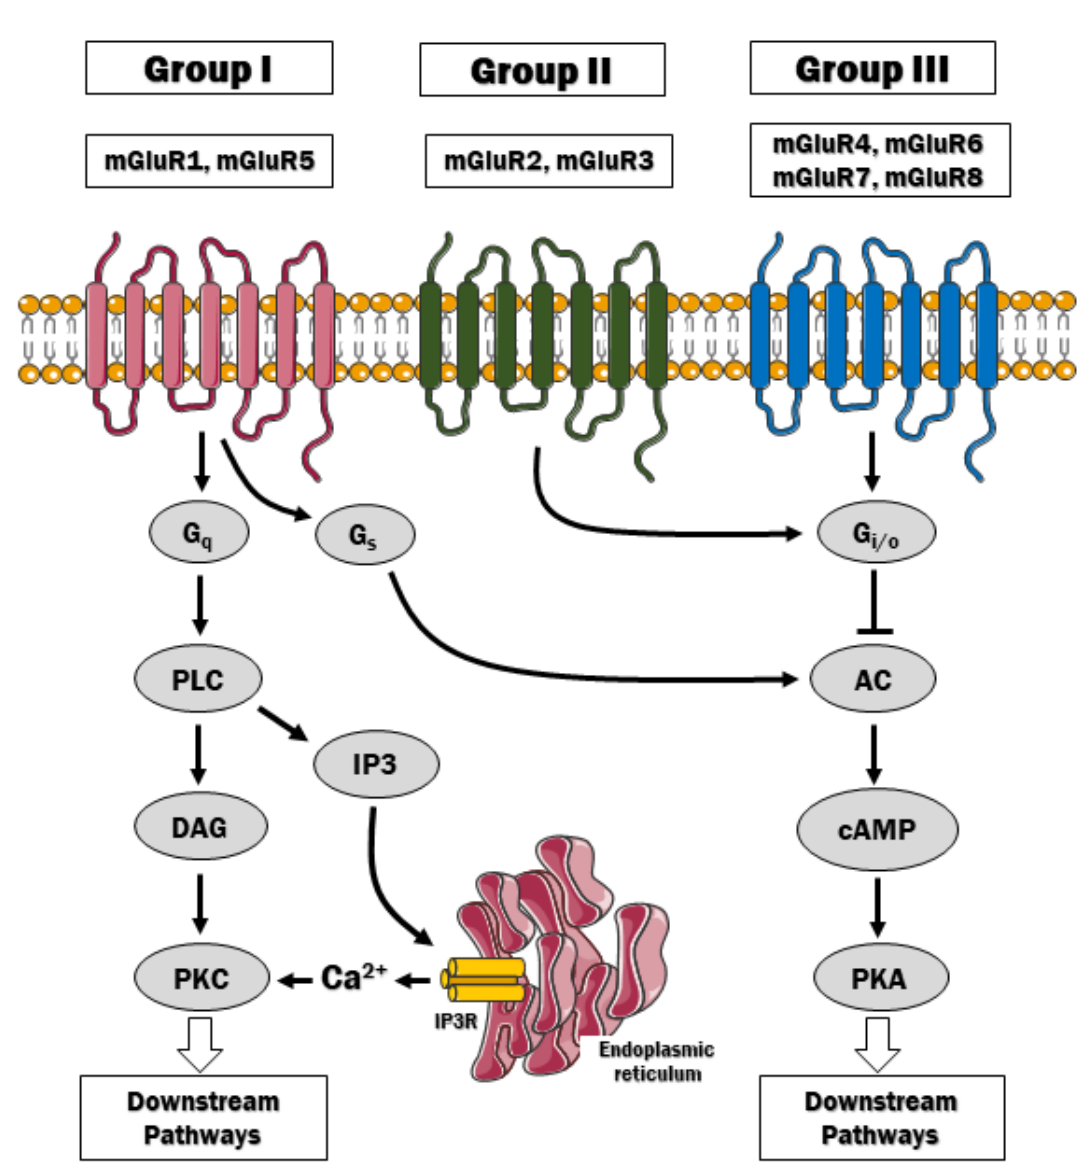
Figure 1. The signaling pathways downstream mGluRs. Group I mGluR is coupled to G q protein, which stimulates phospholipase C (PLC) and the hydrolysis of phosphatidylinositol 4,5-bisphosphate (PIP 2 ). PIP 2 hydrolysis gives rise to inositol (1,4,5)-triphosphate (IP 3 ) and diacylglycerol (DAG). The IP 3 diffuses freely to the endoplasmic reticulum and activates the IP 3 receptors to release Ca 2+ to the cytosol. By contrast, mGluRs of group II and III classically couple to G i/o proteins and inhibit adenylyl cyclase, thus affecting downstream signaling pathways via liberation of Gβγ.